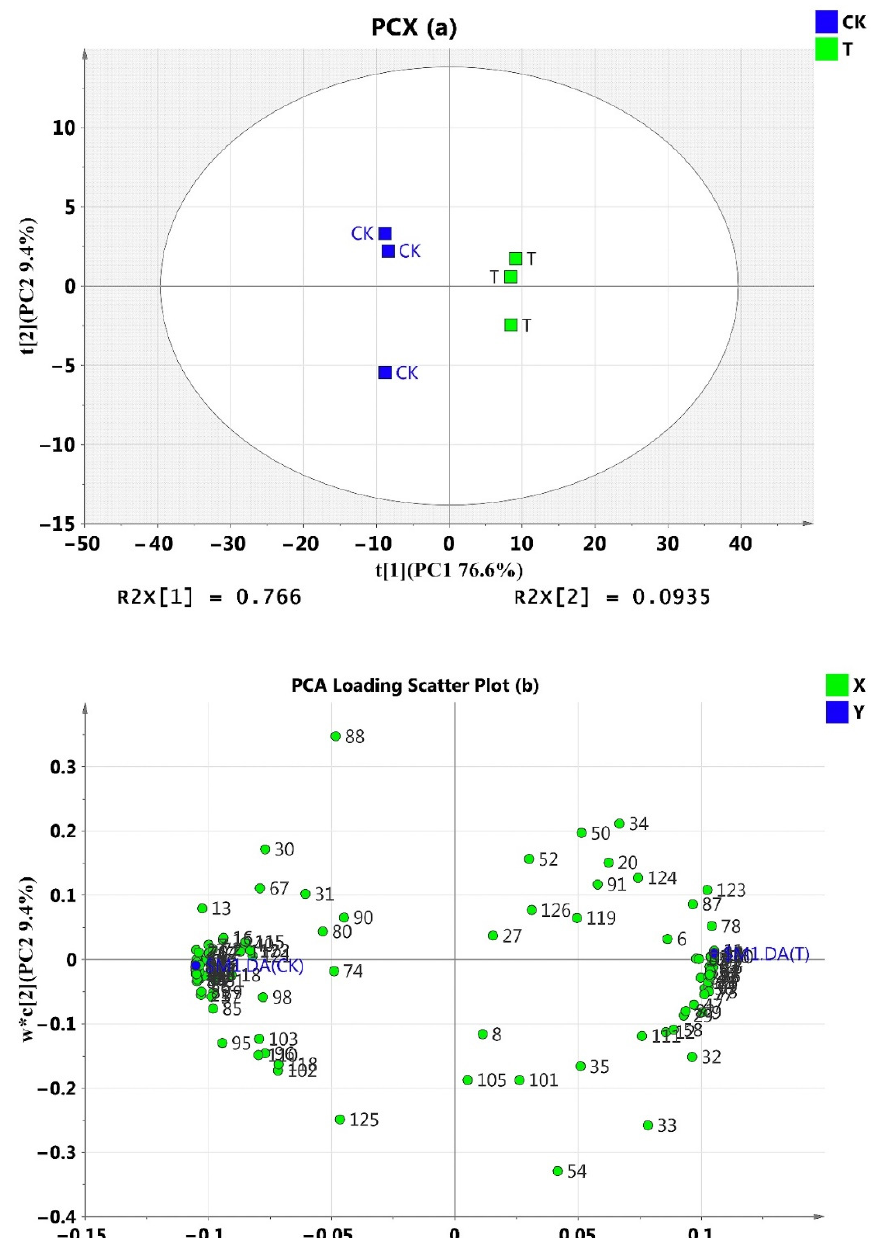
Figure 3. Principal component analysis ( a ) and loading scatter plot ( b ) of metabolites in tobacco seedlings (X (green) and Y (violet) represent the metabolites and sample center